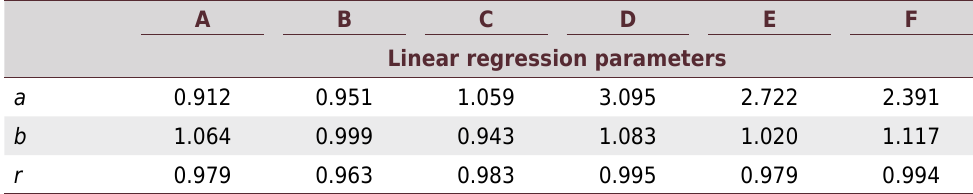
Table 2. Diffusivity-depth linear regression parameters